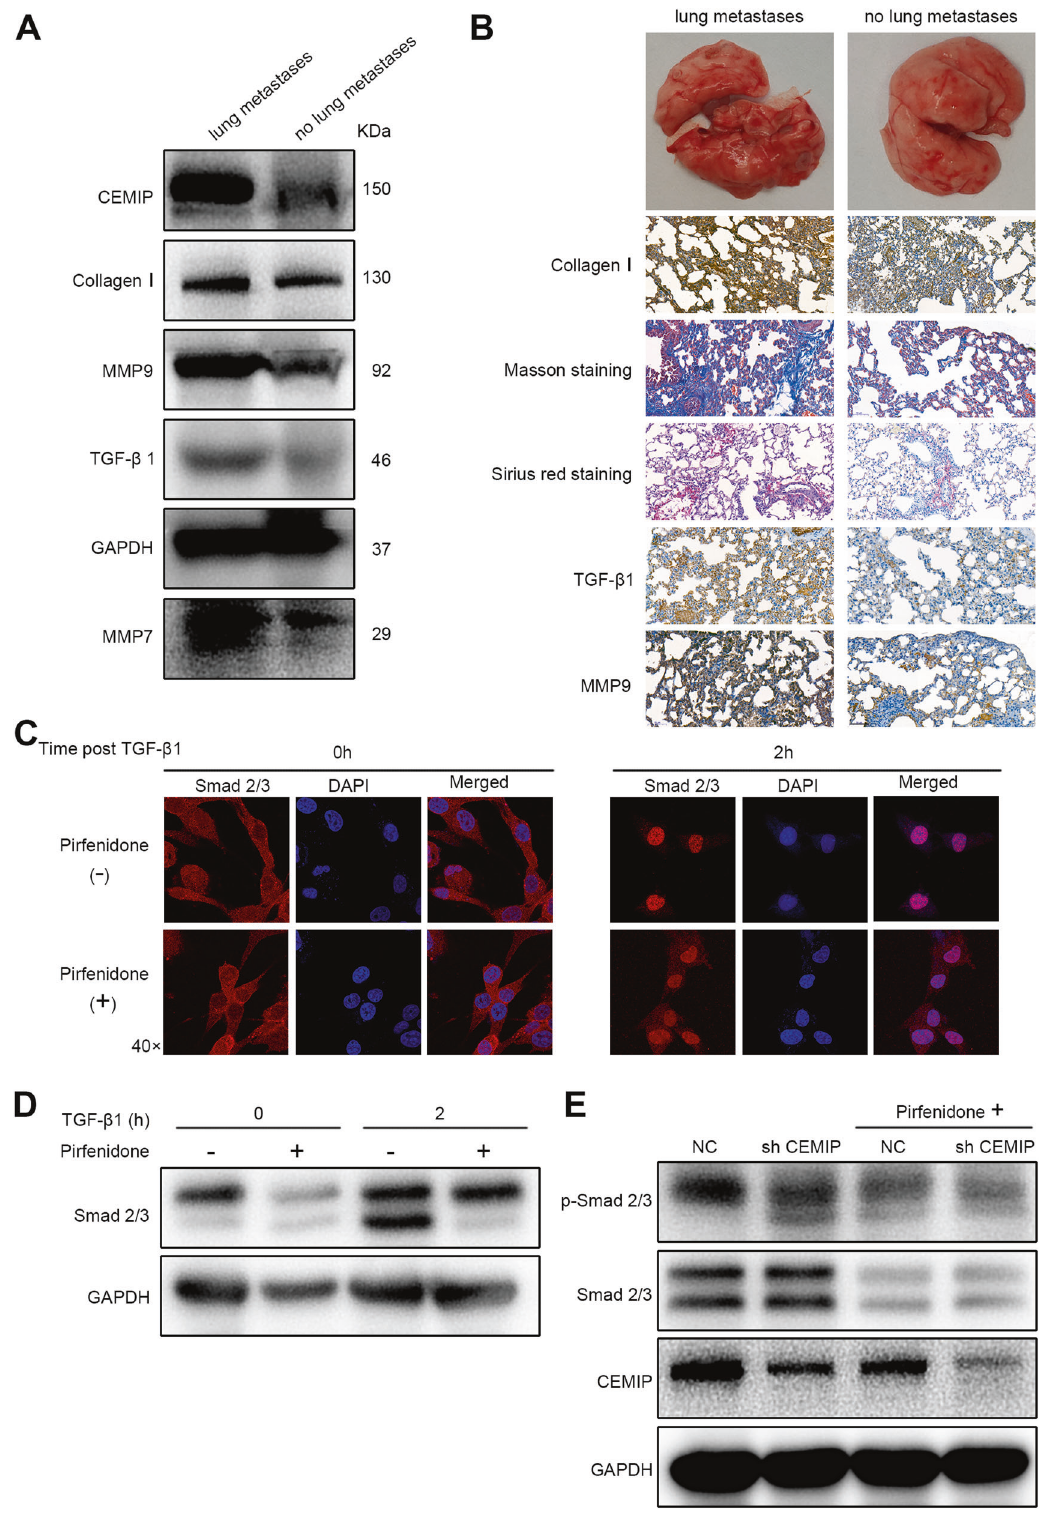
Fig. 5 The pirfenidone-induced reduction of CEMIP may inhibit the canonical TGF- β -Smad signaling. A , B The evaluation of lung tissues via western blotting and IHC proved that matrix stiffening was observed in mice with or without lung metastasis. Scale bar = 50 μ m. C MRC5 fi broblasts were treated with or without 2 mg/mL pirfenidone for a total of 12 h and 10 ng/mL TGF- β 1 for 2 h. Representative immuno fl uorescence images demonstrate the nuclear accumulation of Smad2 reduced after pirfenidone treatment (magni fi cation ×40). D MRC5 fi broblasts were treated with 2 mg/mL pirfenidone for a total of 12 h and 10 ng/mL TGF- β 1 for 2 h. Protein lysates were analyzed via western blotting. Pirfenidone treatment resulted in a reduction in Smad2 and Smad3 post-TGF- β 1 treatment. E The inhibitory effects of pirfenidone on the CEMIP-induced expression of p-Smad2/3 in MRC5 fi broblasts.